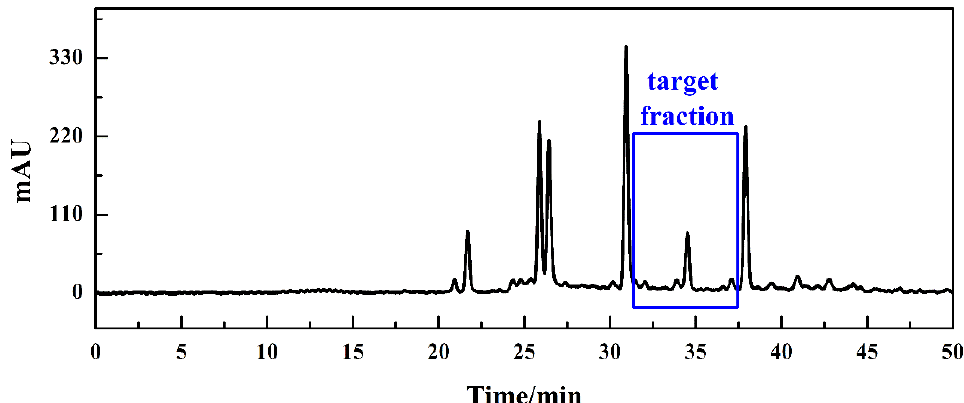
Figure 5. The separation chromatogram of sample Fr-3 on the Odyssil C18 preparative column. Condition: mobile phase A: 0.2% v / v formic acid/water, B: ACN; gradient: 0–50 min, 5–35% B; monitoring wavelength: 254 nm; flow rate: 19.00 mL/min. The target-fraction was framed by the blue line.